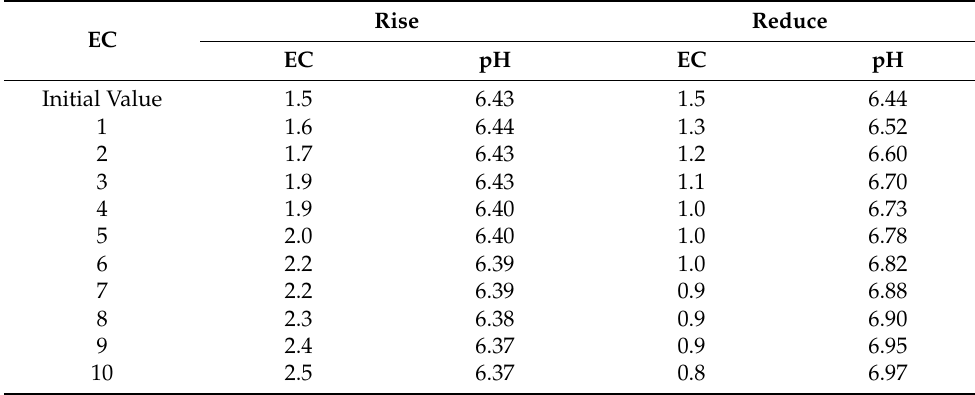
Table 6. Simulated EC rise and reduction experiments.